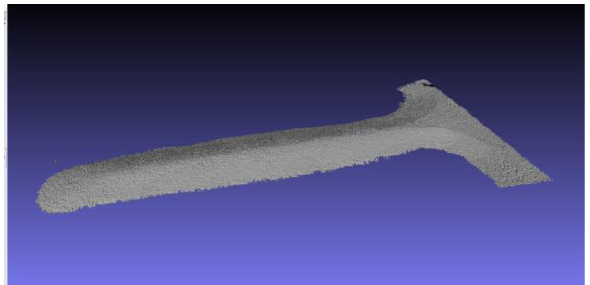
Figure 6. Mesh of reference epoch, closed surface with 20 mm point spacing